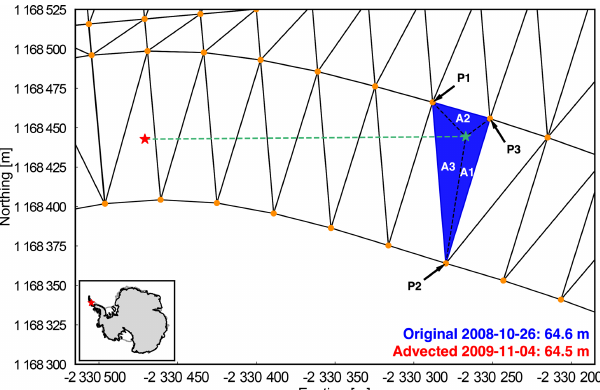
Figure 1. NASA–CECS Pre-IceBridge and NASA Operation Ice- Bridge campaign flight lines over (a) Antarctica, (b) the Antarc- tic Peninsula, and (c) the Amundsen Sea Embayment from 2002 to 2016 colored by year of acquisition and laser ranging instrument. Antarctic grounded ice delineation provided by Mouginot et al. (2017b). Flight lines overlaid on a 2008–2009 MODIS mosaic of Antarctica (Haran et al., 2014).